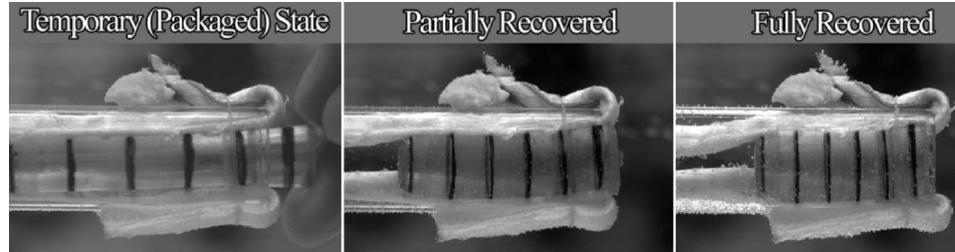
Figure 6. A shape memory polymer cylindrical that expands at body temperature. Reprinted with permission [93].